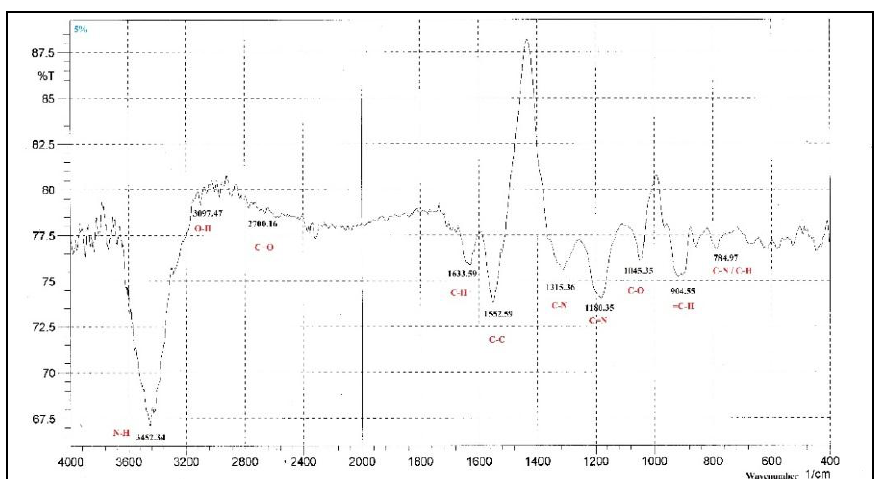
Fig.8: (c) FTIR spectra of PPy with (5%) of GN